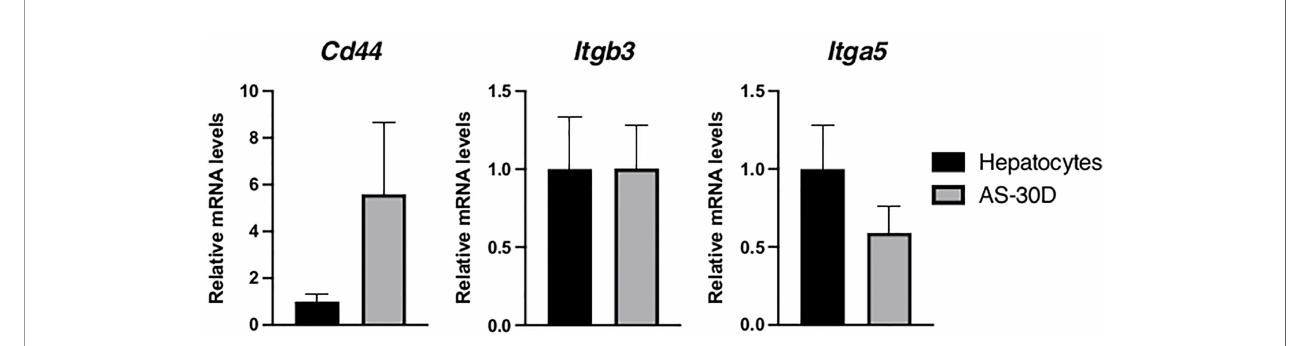
FIGURE 5 | Gene expression of canonical receptors recognizing OPN in rat hepatocytes and AS-30D cells. Rat hepatocytes were freshly isolated, and AS-30D samples were obtained from cells from the ascitic fl uid of experimental rats. Data represented as mean ± SD.